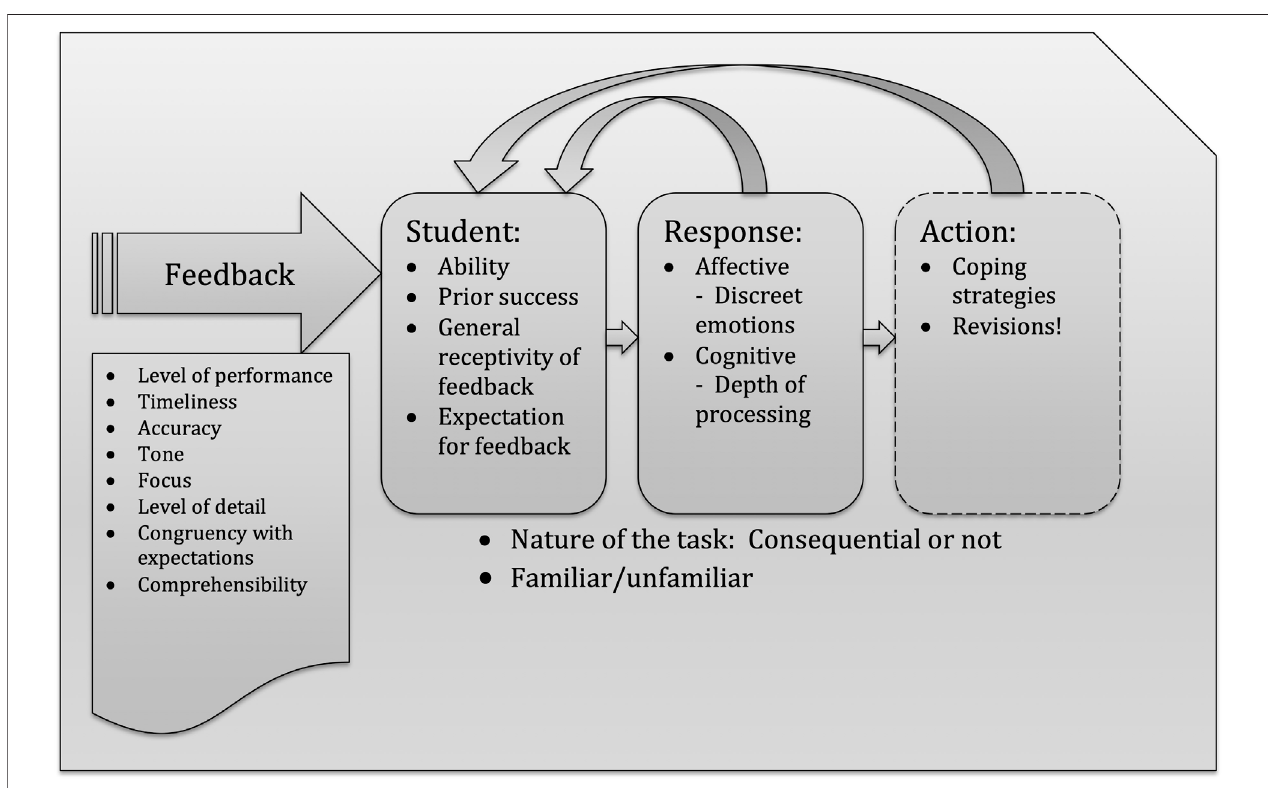
FIGURE 14 | Lipnevich et al. (2016) Feedback – student interaction